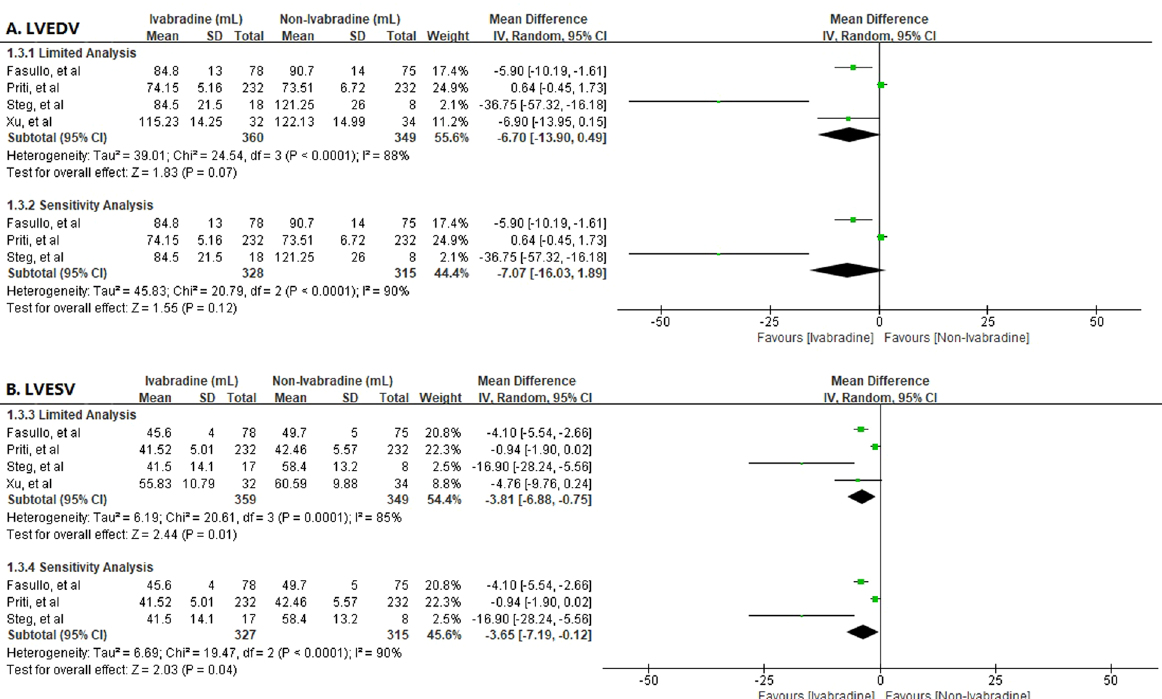
Fig. 4 Effect of Ivabradine on LV remodeling. A. Left ventricular end diastolic volume (LVEDV); B. Left ventricular end systolic volume (LVESV)